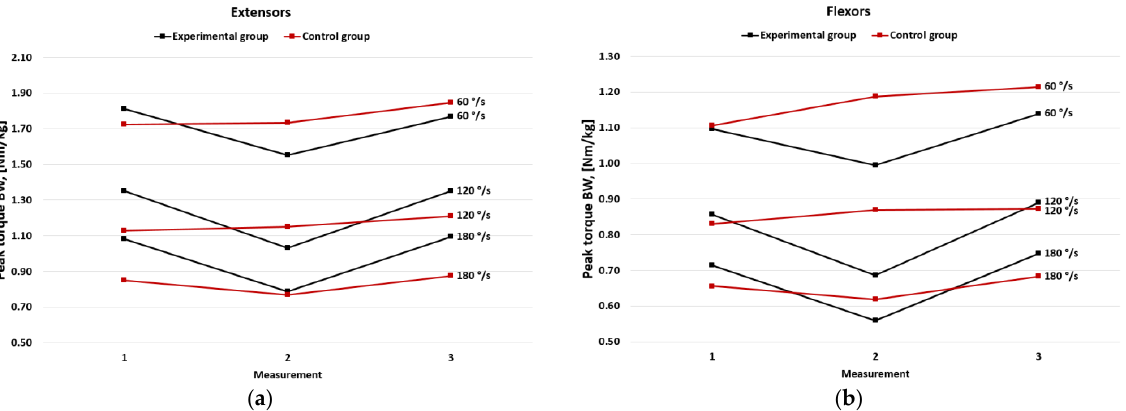
Figure 2. Mean of peak torque per body weight in the experimental and the control group for ( a ) extensors and ( b ) flexors.